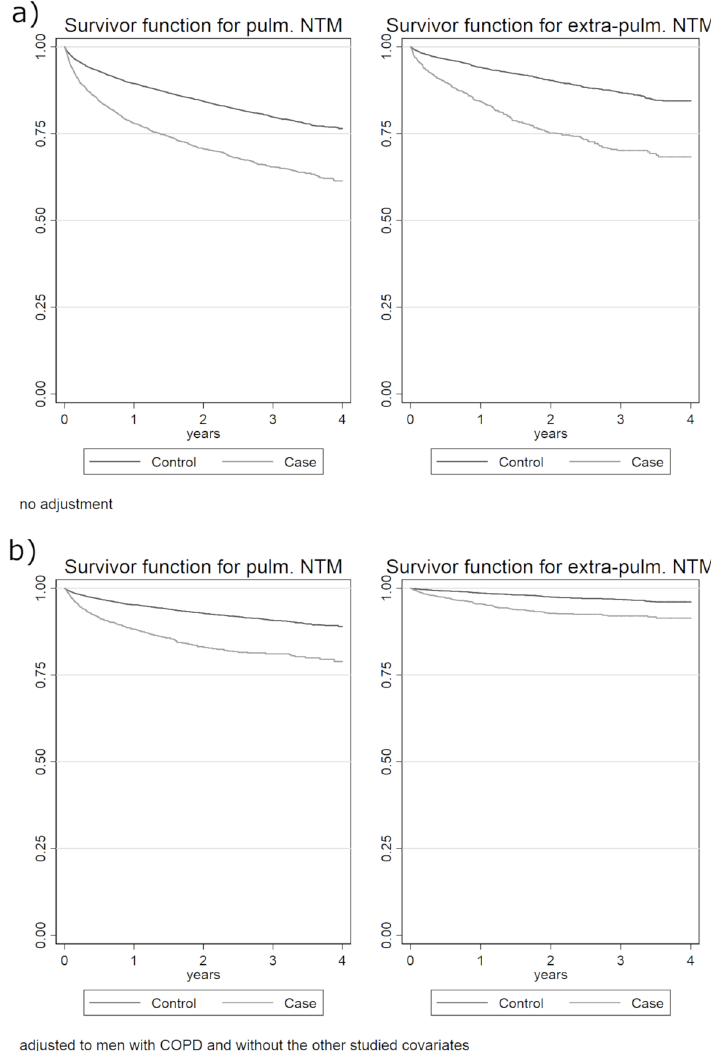
Fig 4. Kaplan-Meier curves of survival after pulmonary and extra-pulmonary NTM diagnosis compared to age- and clinical-setting matched controls.